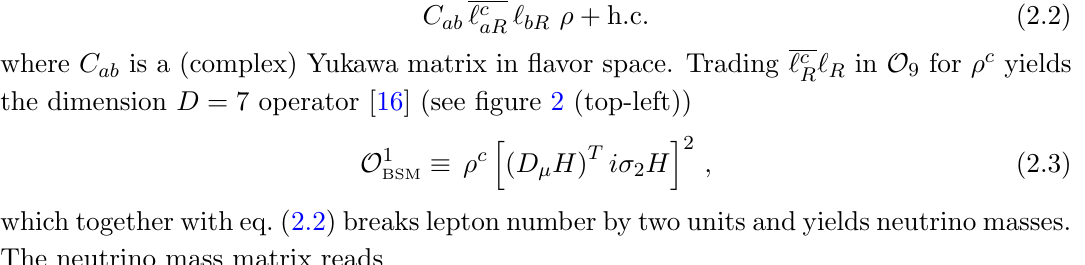
. The crosses O 9